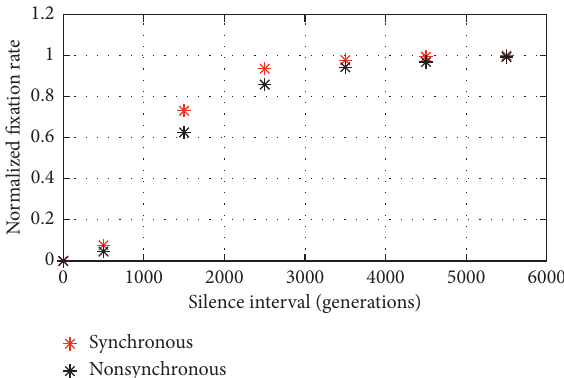
Figure 4: The discrepancies between the fixation rates of the A allele in case of a synchronous activation and a nonsynchronous activation with a standard deviation of two generations.